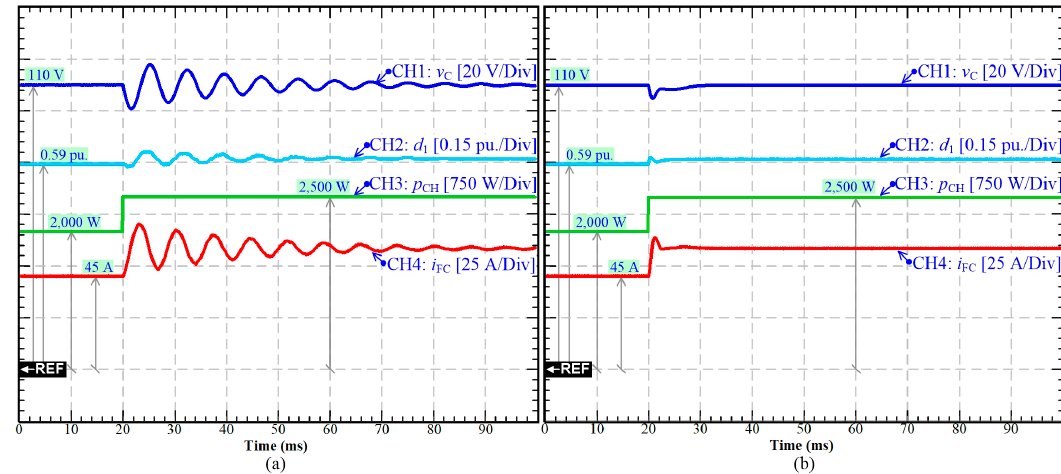
Figure 14. Simulation results: Dynamic behavior of the FC converter during a CPL step: 2000 W to 2500 W: ( a ) linear PI control law; ( b ) proposed adaptive Hamiltonian PI control law.